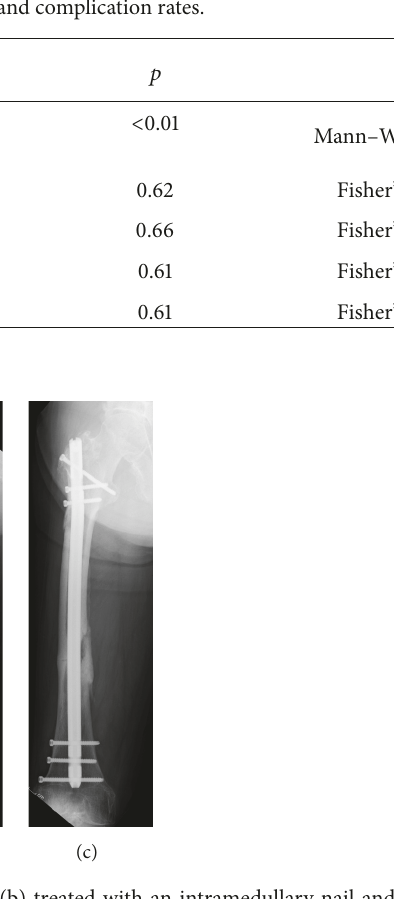
Figure 1: (a) AP radiographs of a patient with atypical femoral shaft fracture (b) treated with an intramedullary nail and intraoperative peri-implant fracture occurred. (c) Bone healed after 32 weeks from the index